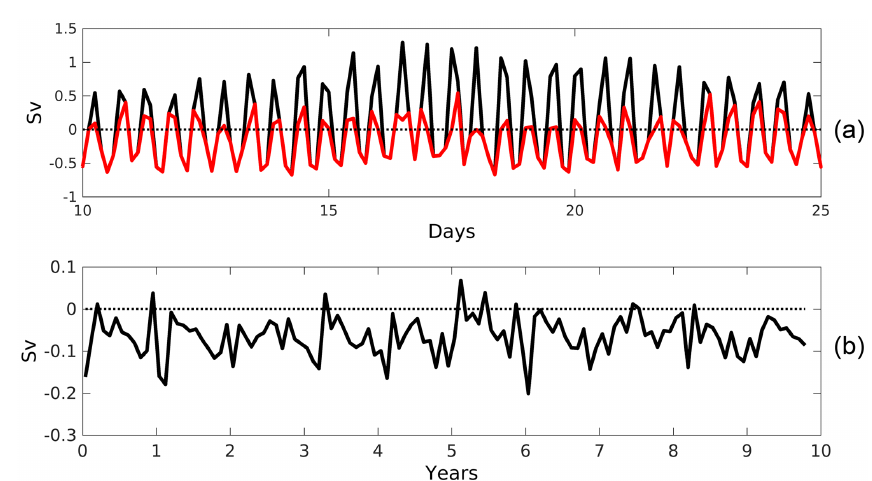
Figure 5. (a) 3-hourly vertical transfers (black line) between the inflow and outflow layers computed as the difference in the outflow transport between the Gulf of Cádiz and the Alboran Sea. The effective recirculation of water between layers (red line) is also plotted. Positive values indicate transport of water from the outgoing layer to the incoming layer (only a 15-day period is shown for clarity). (b) Low frequency transfer and recirculation computed from monthly averages of the transport. Note that the vertical and horizontal scales are different in both plots. Table 2. Mean values and standard deviation of the monthly temperature ( ◦ C) and salinity (psu) values for the inflow and outflow at the outermost cross-strait sections (Gulf of Cádiz and Alboran). The results are shown for the run including tidal forcing and the run without the tidal forcing. TIDAL RUN NON-TIDAL RUN Gulf of Cádiz Alboran Difference Gulf of Alboran Difference Alboran – Cádiz Alboran – G. Cádiz G.